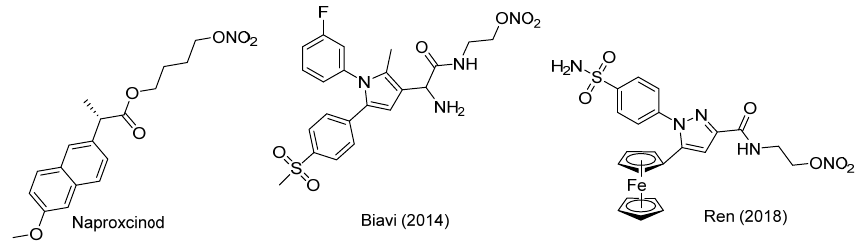
Figure 1. Molecular structures of COX inhibitors with NO • releasing functionalities